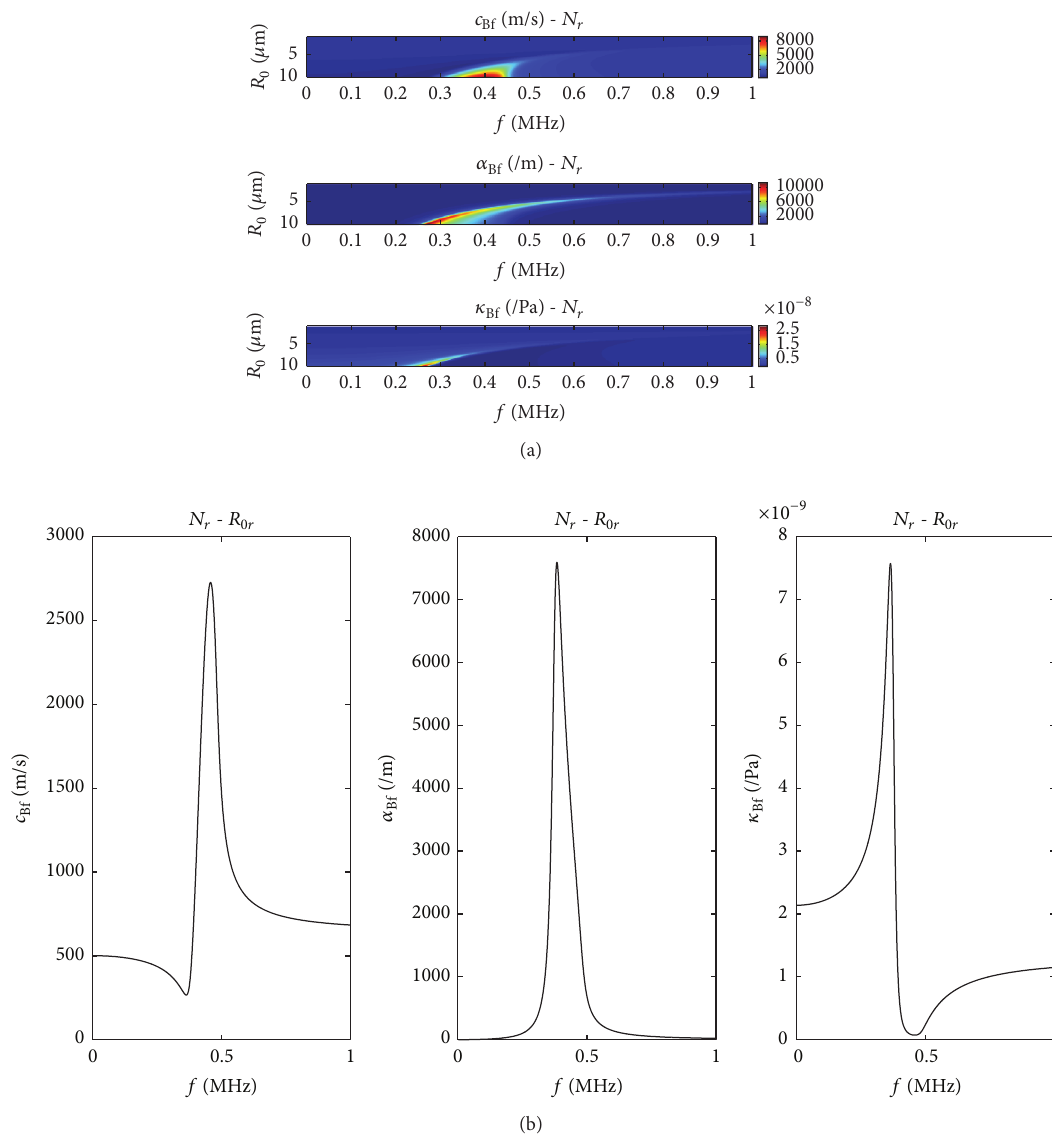
Figure1:Soundspeed,attenuationcoefficient,andcompressibilitycoefficientofthebubblyliquid(a)versusbubblesizeanddrivingfrequency and (b) versus driving frequency for the specific bubble radius 𝑅 0𝑟 = 7 𝜇 m. Bubble density is 𝑁 𝑟 = 1 × 10 11 / m 3 .